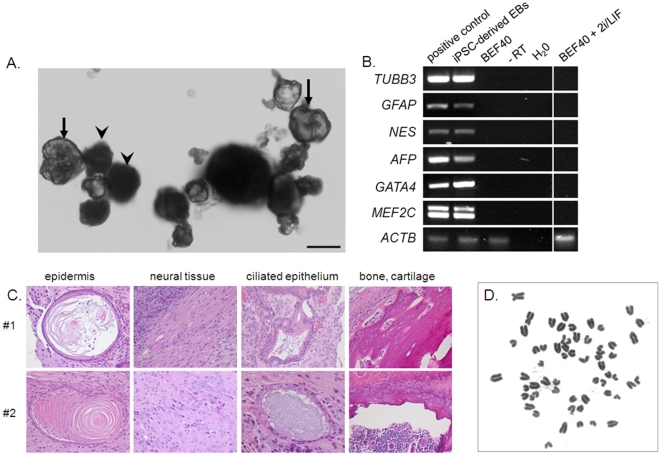
Differentiation of bovine iPSC-like colonies in vitro and in teratomas.(A) Simple (arrowheads) and cystic (arrows) EBs. Scale bar  = 50 µm. (B) RT-PCR analysis of differentiation marker expression in cystic EBs. cDNA from bovine fetal brain (ectoderm), gut (endoderm) and heart (mesoderm) provides a positive control. (C) Histological sections of intramuscular teratomas from different pools of colonies (#1, #2). (D) Karyotype of bovine iPSC-like cells after 24 days in culture.